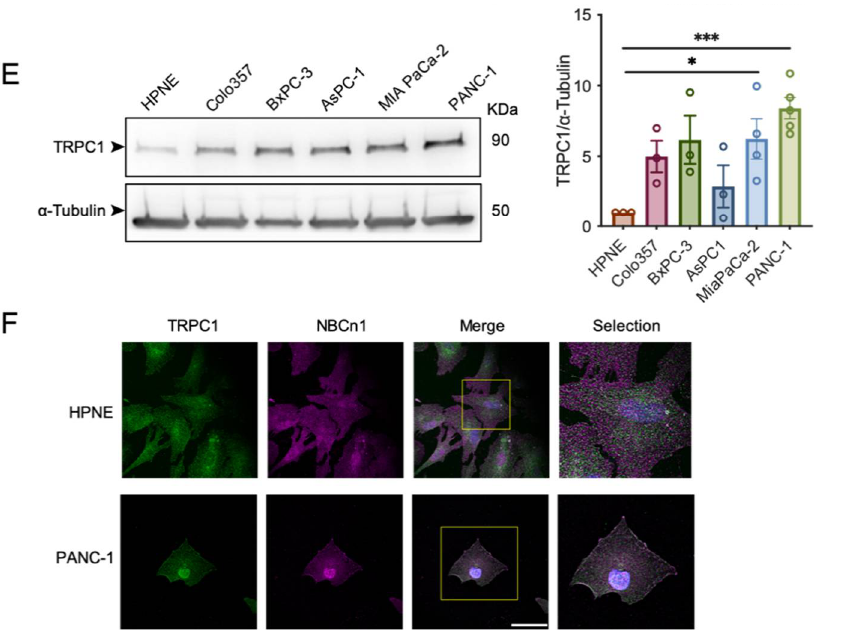
Figure 2. TRPC1 is overexpressed in PDAC tissue and cell lines, where it localizes to the plasma membrane. ( A ) Representative images of TRPC1 expression in human PDAC tissue, performed by immunohistochemistry (IHC). White arrows indicate expression in the cytoplasm (left panel) and the plasma membrane (right panel). Inserts represent negative controls, scale bar = 40 µm. ( B ) Quantification of TRPC1 marking intensity score between non-tumor and tumor tissue (N = 21). ( C ) Quantification of TRPC1 expressed in the cytoplasm and ( D ) membrane (N = 21). ( E ) Western blot analysis (left panel) and quantification (right panel) of TRPC1 expression in commercial-available PDAC cell lines ( n = 3–5). ( F ) Representative immunofluorescent analysis of TRPC1 in HPNE and PANC-1 cells ( n = 3), scale bar = 20 µm. Welch’s correction t-test was used to determine the significant difference between control and tumor conditions. *, *** and **** indicate p < 0.05, 0.01, 0.001, and 0.0001, respectively.